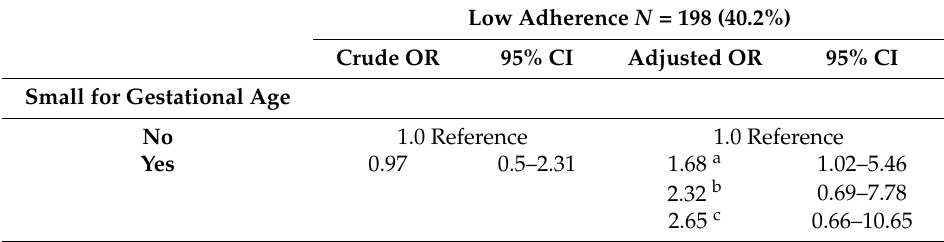
Table 3. Risk of small for gestational age infants due to low adherence to Mediterranean diet. Low Adherence N = 198